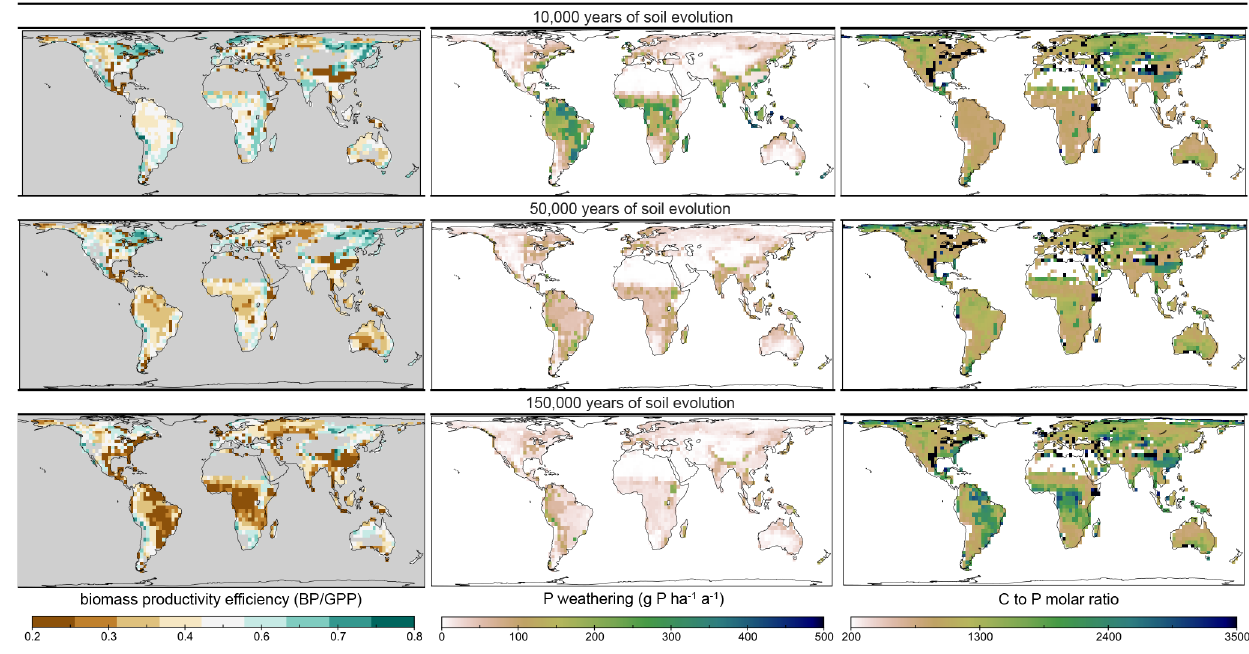
Figure 12. Biomass production efficiency (BPE), P weathering rates, and C to P molar ratio in vegetation changes during pedogenesis. Top plots represent the dynamics in recent soils (after about 10000yr of soil evolution). The intermediate plots represent intermediate soil ages of about 50000yr and the bottom plots represent old soils after about 150000yr of soil evolution. Biomass production is more efficient in temperate regions in both young and old soils. In tropical regions, BPE decreased in time, reaching a status of very low efficiency, particularly in central Africa and Western South America. P weathering rates (central panels) decrease everywhere with time. In the oldest soils, weathering is high in places at high elevations. Locations with shale lithology also produced relatively high weathering rates, compared to those with sandstone. The C to P molar ratio in vegetation increased in time. In tropical regions, the ratio was correlated with weathering